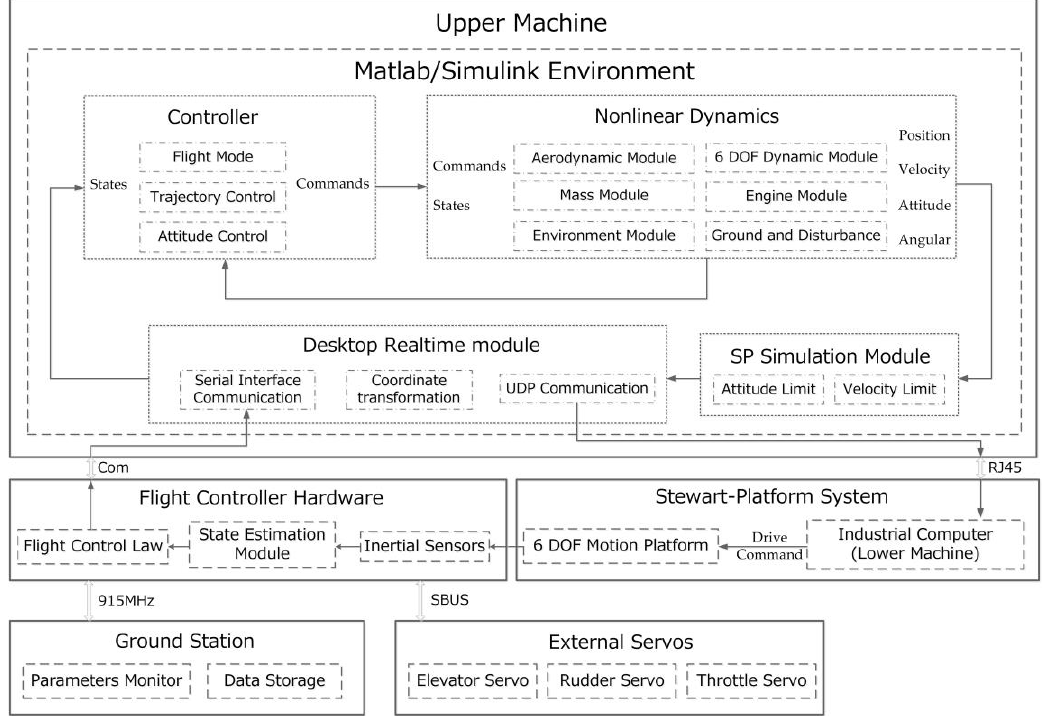
Figure 14. Schematic diagram of the UAV hardware-in-the-loop-simulation (HILS).